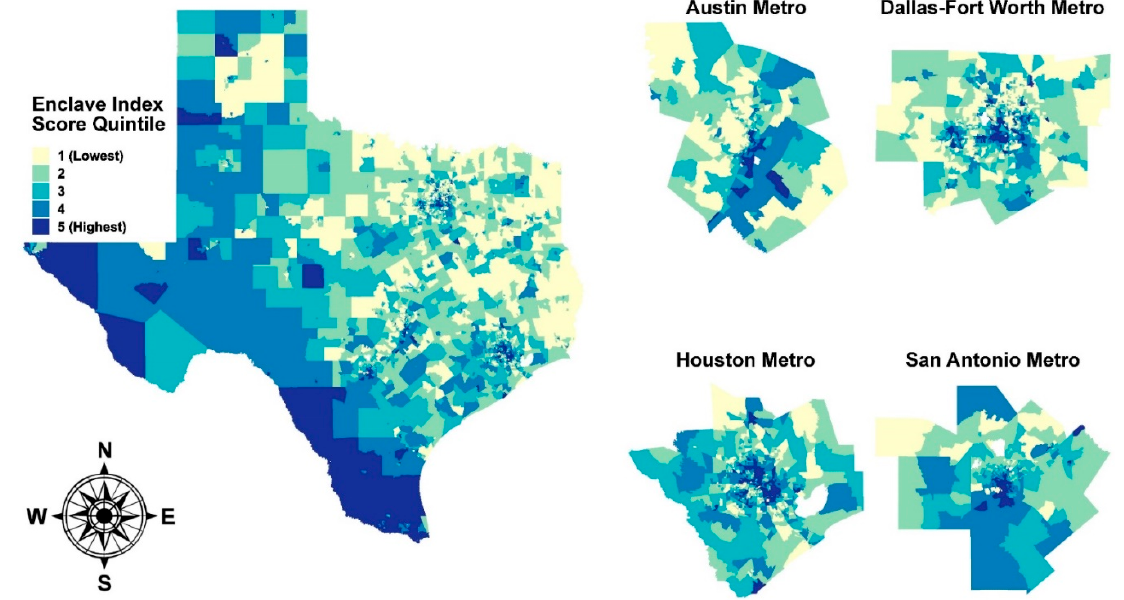
Figure 1. Distribution of Hispanic enclave index scores in Texas and selected metropolitan statistical areas. Enclave index scores were divided into quintiles based on their statewide distribution. For visualization purposes, scores were computed using 2010 U.S. Census data.